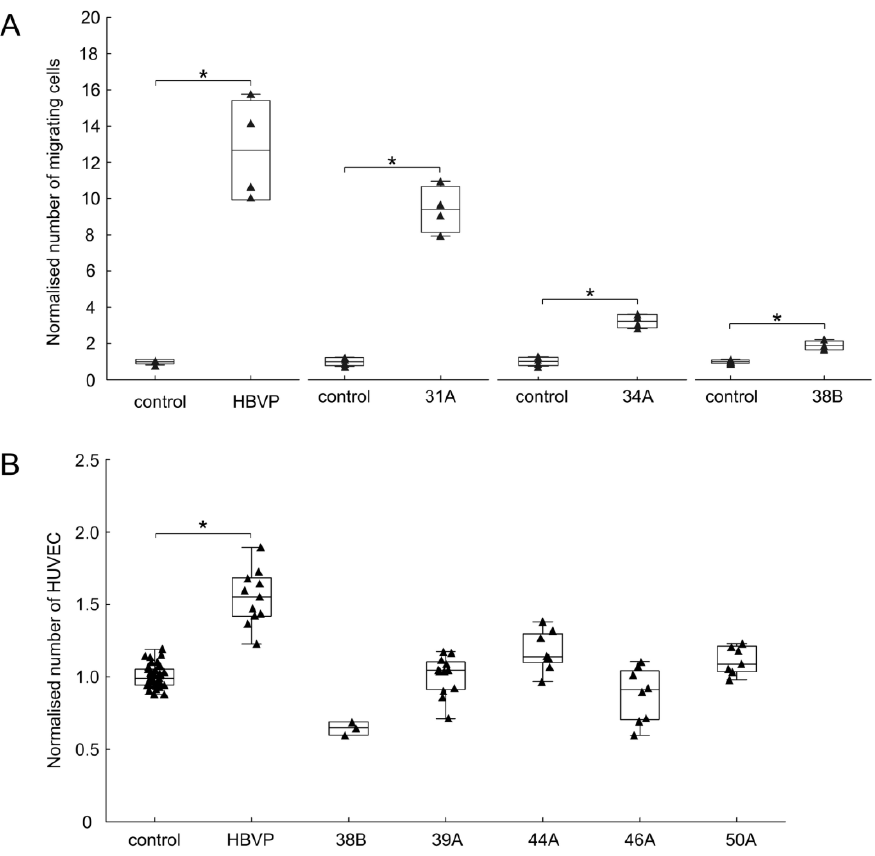
Figure 4. FAP + mesenchymal cells enhance the migration of endothelial cells. ( A ) Chemotaxis of human umbilical vein endothelial cell (HUVEC) towards control (non-conditioned) medium and towards conditioned media from FAP + mesenchymal cells (31A, 34A, 38B) and human brain vascular pericytes (HBVP), respectively. Cell migration was evaluated using a modified Boyden transwell migration assay after 24 h. Data in each experiment were normalised to control. One experiment for each conditioned medium from a particular cell culture performed in quadruplicates. Line—mean, box—mean ± SD, whiskers—range, triangles—raw data. * p < 0.05 compared to the corresponding control, Welsch’s t -test. ( B ) Effect of FAP + mesenchymal cells on the growth of HUVEC in a direct co-culture system. HUVEC were grown alone or mixed with mitomycin-pretreated HBVP or FAP + stromal cells (38B, 39A, 44A, 46B, 50A), the number of HUVEC cells was evaluated after 120 h. Results from three (HBVP) and two (39A, 44A, 46A, 50A) independent experiments performed in quadruplicates, and one (38B) experiment in triplicates. Data in each experiment were normalised to HUVEC grown alone. Line—median, box—25th to 75th percentile, whiskers—non-outlier range, triangles—raw data. * p < 0.05 compared to control, Kruskal-Wallis